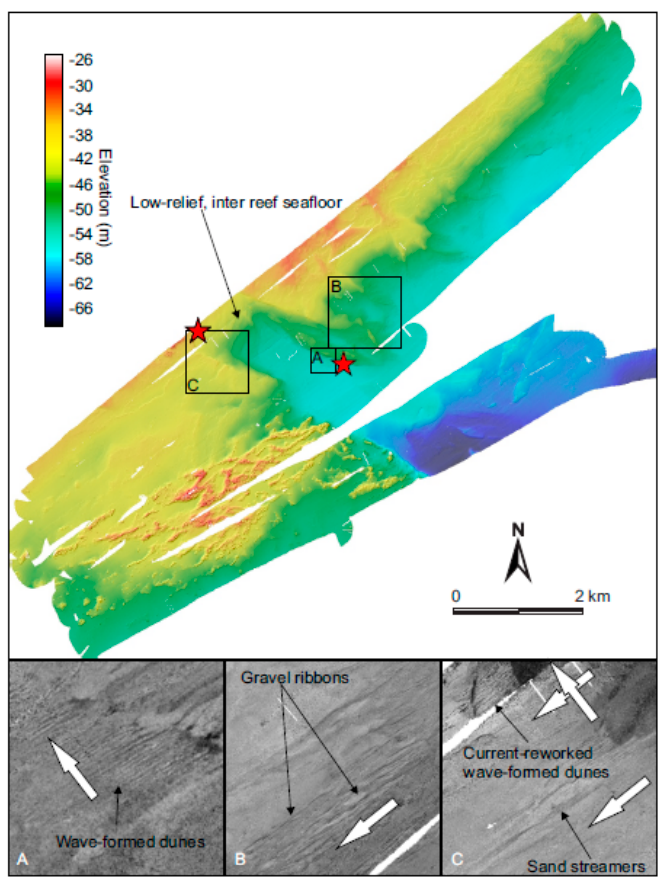
Figure 6. Multibeam image of the mid-shelf offshore the Kei River mouth. Red stars denote rhodoliths observed from ROV surveys. Note the association with low relief, inter reef areas. Insets depict select areas of seafloor backscatter data (dark—high, light—low), with current direction denoted by white arrows. A , Coast-parallel, wave-formed dunes. B , Coast-elongate, high backscatter ribbons denoting gravel streamers formed by the Agulhas current. C , Top of inset shows wave-formed dunes, broken down and reworked by coast-parallel flows. Bottom shows elongate, coast-parallel stripes of moderate backscatter interpreted as sand streamers formed in the Agulhas current.